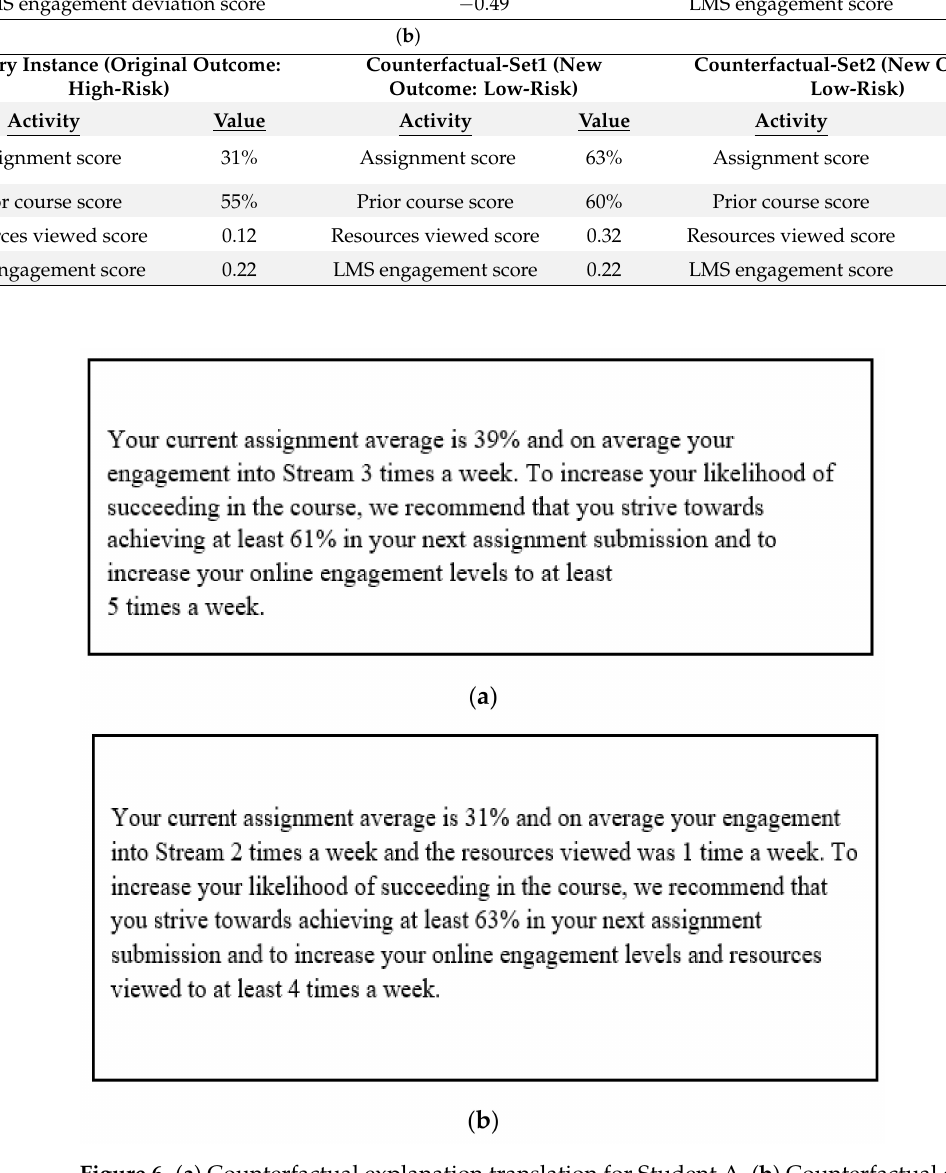
Figure 6. ( a ) Counterfactual explanation translation for Student A. ( b ) Counterfactual explanation translation for Student